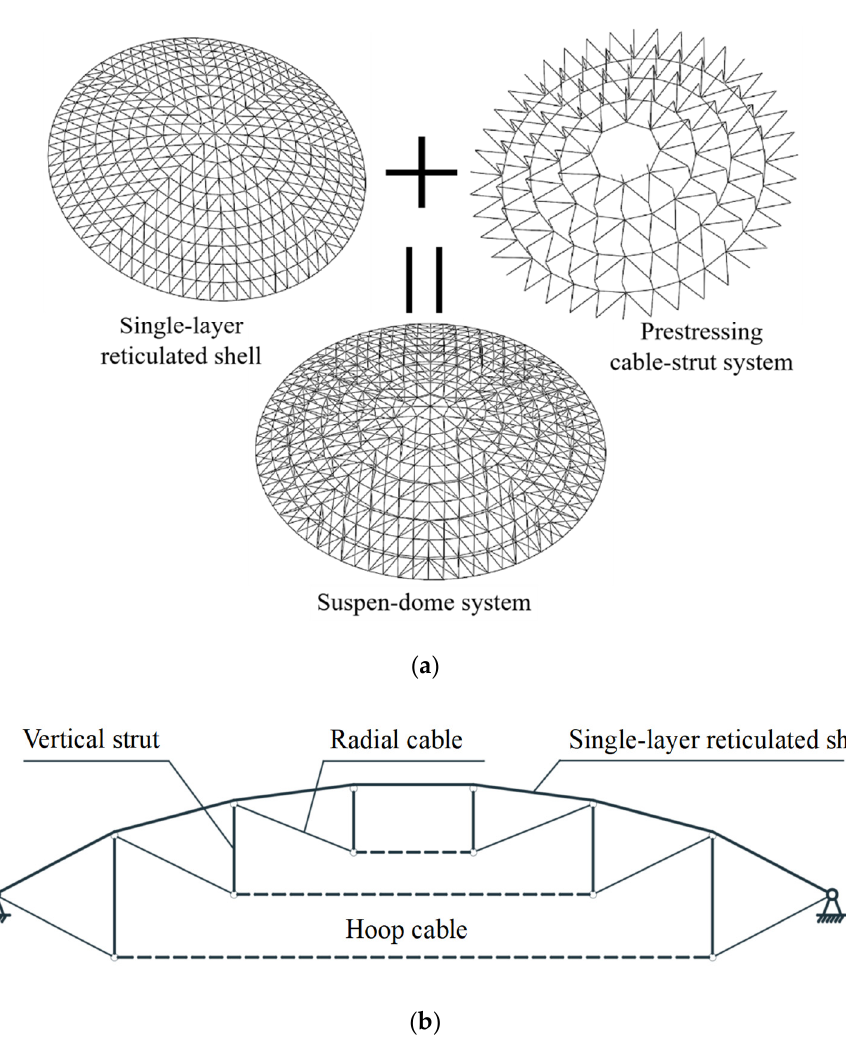
Figure 1. Suspen-dome structure: ( a ) Basic composition of suspen-dome structure; ( b ) Sectional view of the structure.